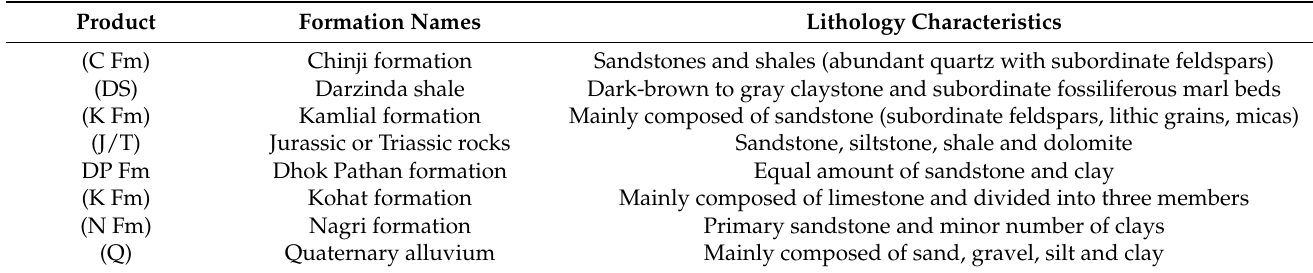
Table 1. Lithological characteristics of the Karak watershed.